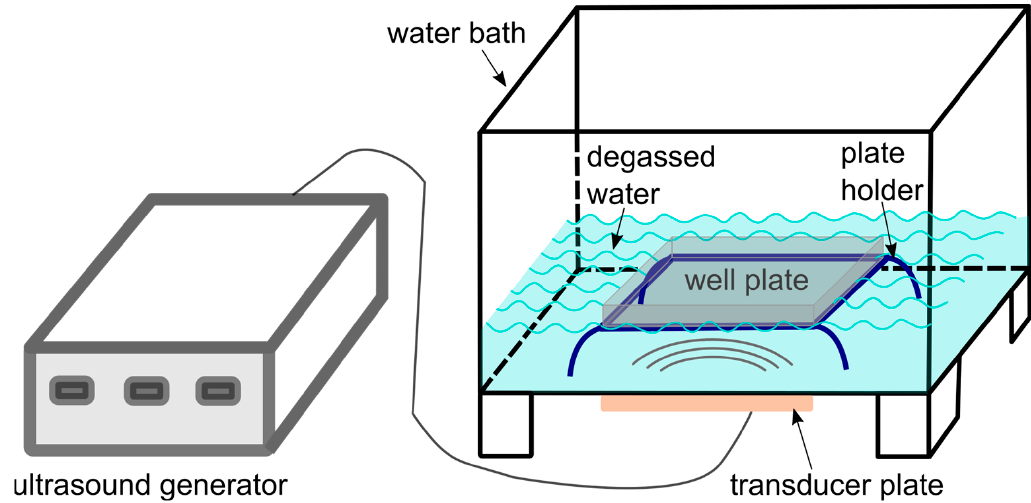
Figure 7. Diagram of the ultrasound exposure equipment.